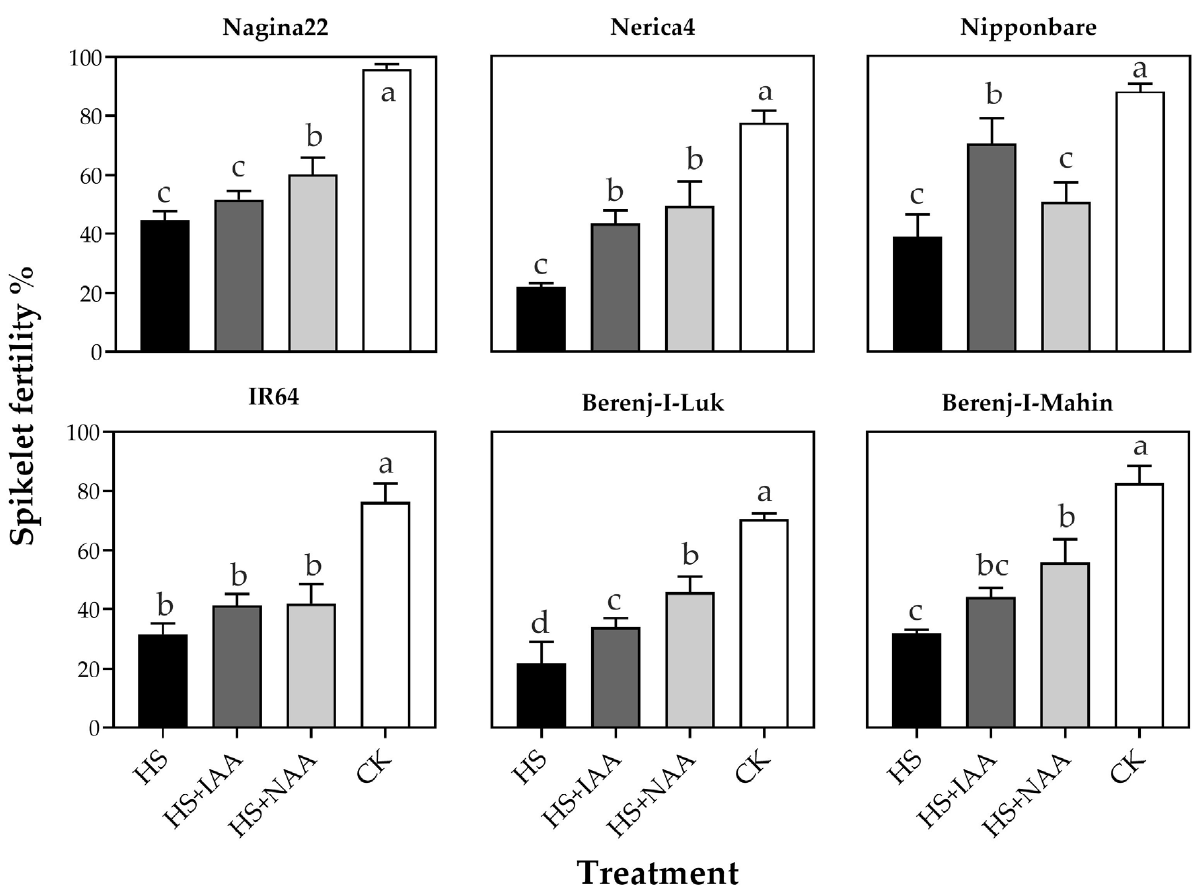
Figure 3. The effects of auxin application on spikelet fertility percentage of six rice genotypes under heat stress conditions. Vertical error bars denote the standard error ( n = 5). Different letters indicate significant differences among four treatments for the same genotypes at the p < 0.05 level.